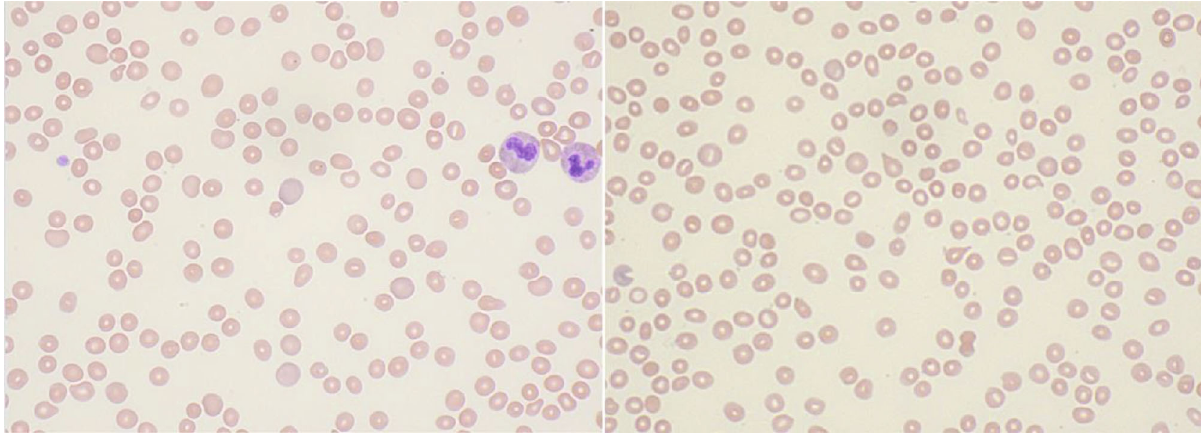
Figure 1: Peripheral blood smear showing microcytic, slightly hypochromic anemia with anisocytosis and polychromasia, thrombocytopenia, and slight leukocytosis. Teardrop cells, reticulocytes, and small spherocytes are present. No overt schistocytes, fragmentation of red blood cells, overt dysplasia, or presence of blasts noted.